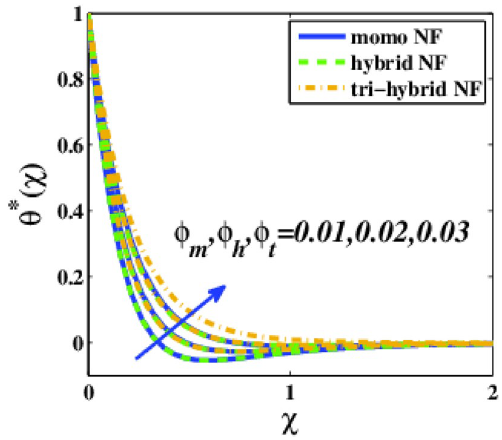
Figure 20. Power of φ on θ ∗ (χ) .